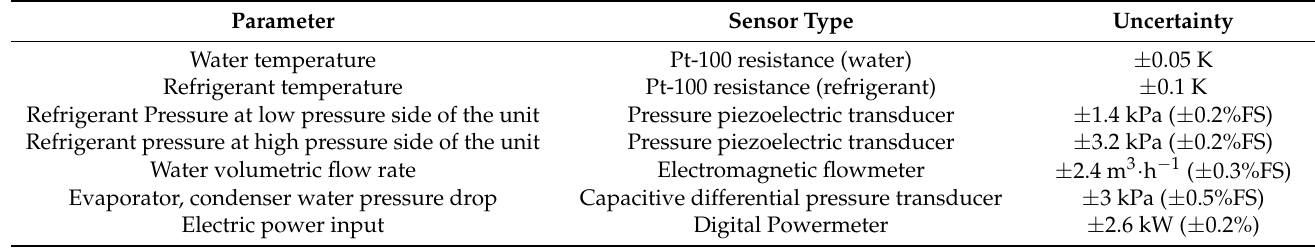
Table 1. Measurement parameters and uncertainties.